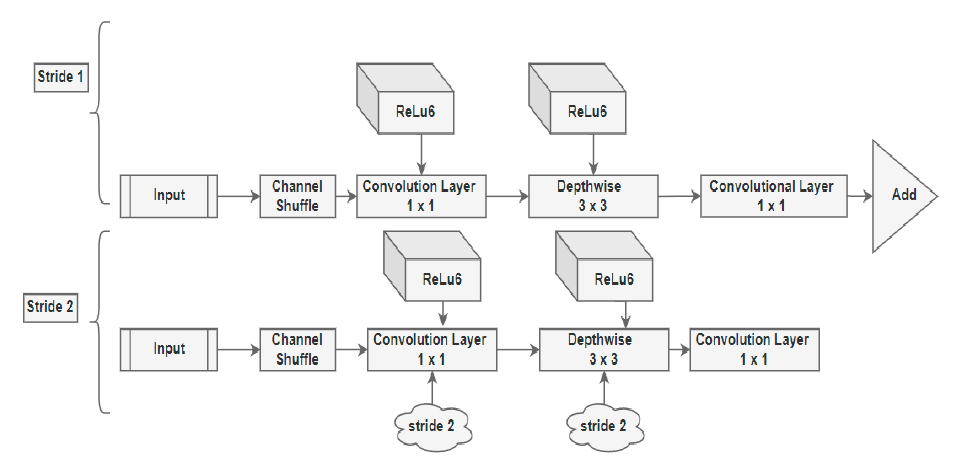
Figure 1. The architecture of MobileNet V2 model.